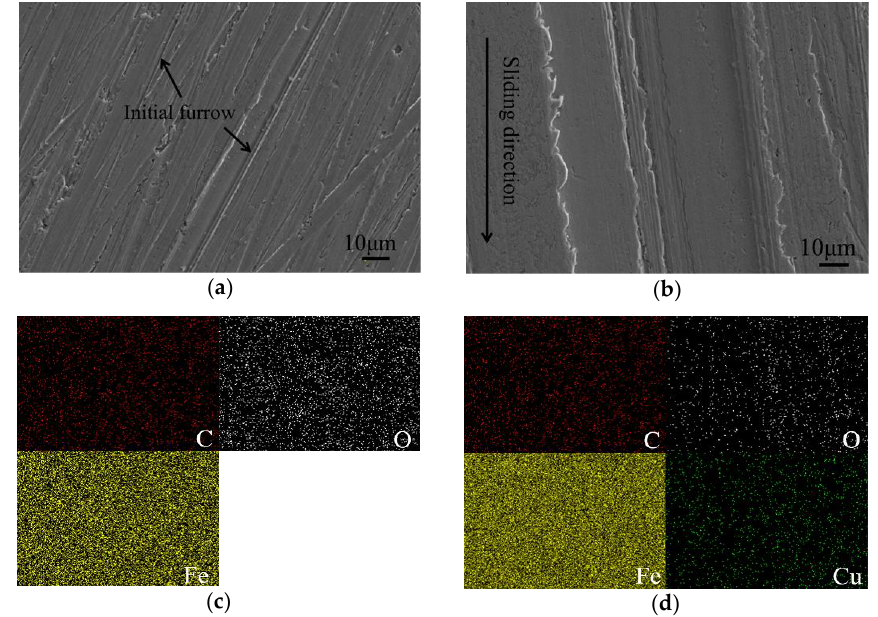
Figure 5. SEM results on the 38CrMoAlA steel plates: ( a ) on the initial surface, ( b ) on the worn surface, ( c ) mapping scanning results on the initial surface and ( d ) mapping scanning results on the worn surface.